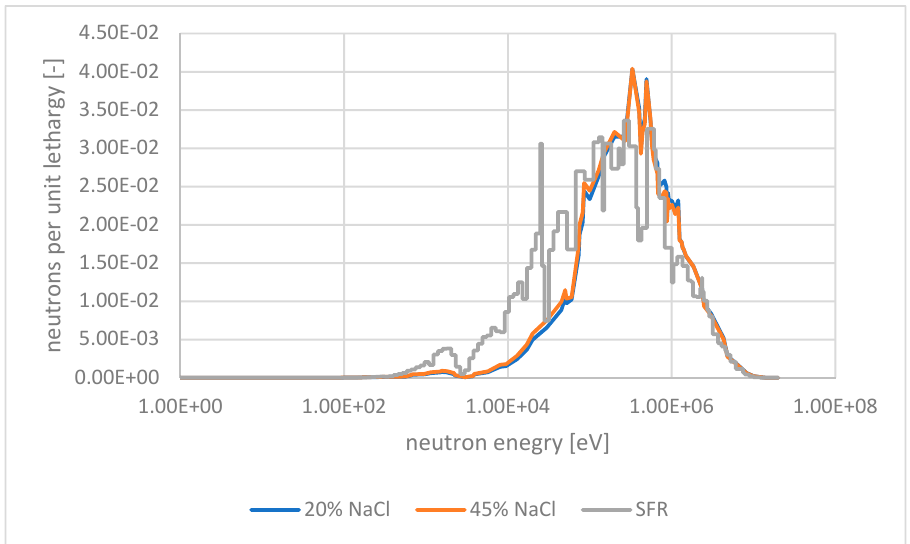
Figure 9. Integral neutron spectrum 35% enriched for the eutectic and the heavy metal rich system in comparison with the neutron spectrum in a classical sodium cooled fast reactor (SFR) fuel assembly of EFR type (calculated through POLARIS, the SFR case is based on HELIOS [24]).